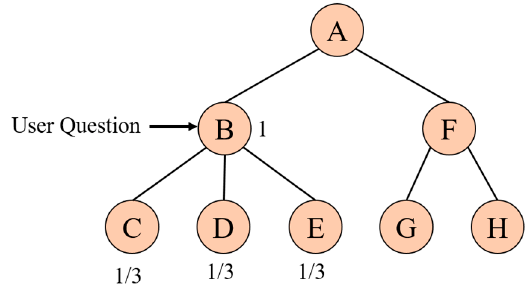
Figure 7. Example of matching a user question with expert groups.